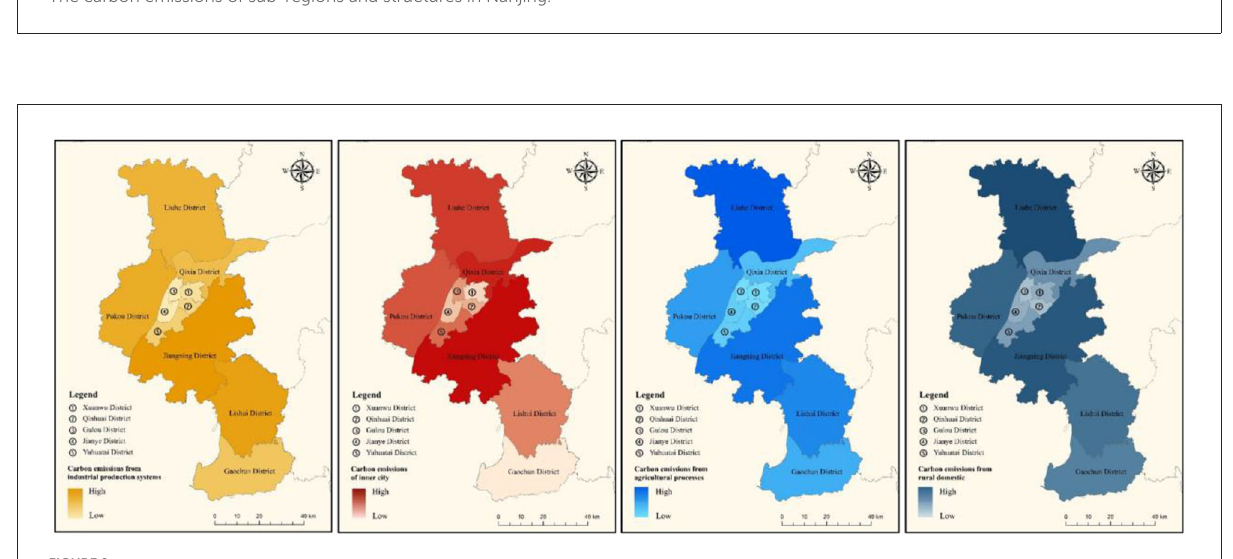
FIGURE9 Spatial pattern of carbon emissions by sectors in